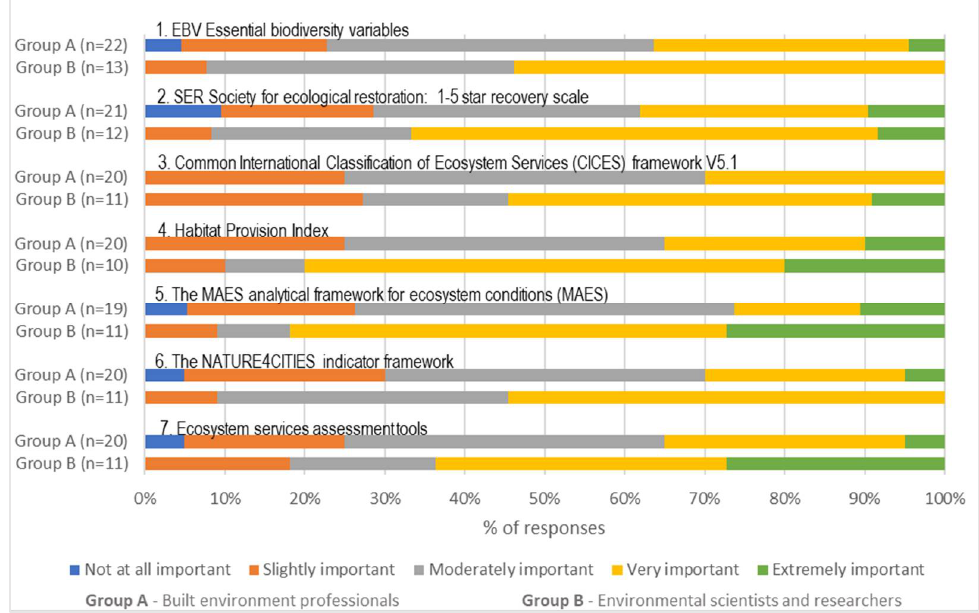
Figure 14. Frameworks for quantifying habitat provisioning